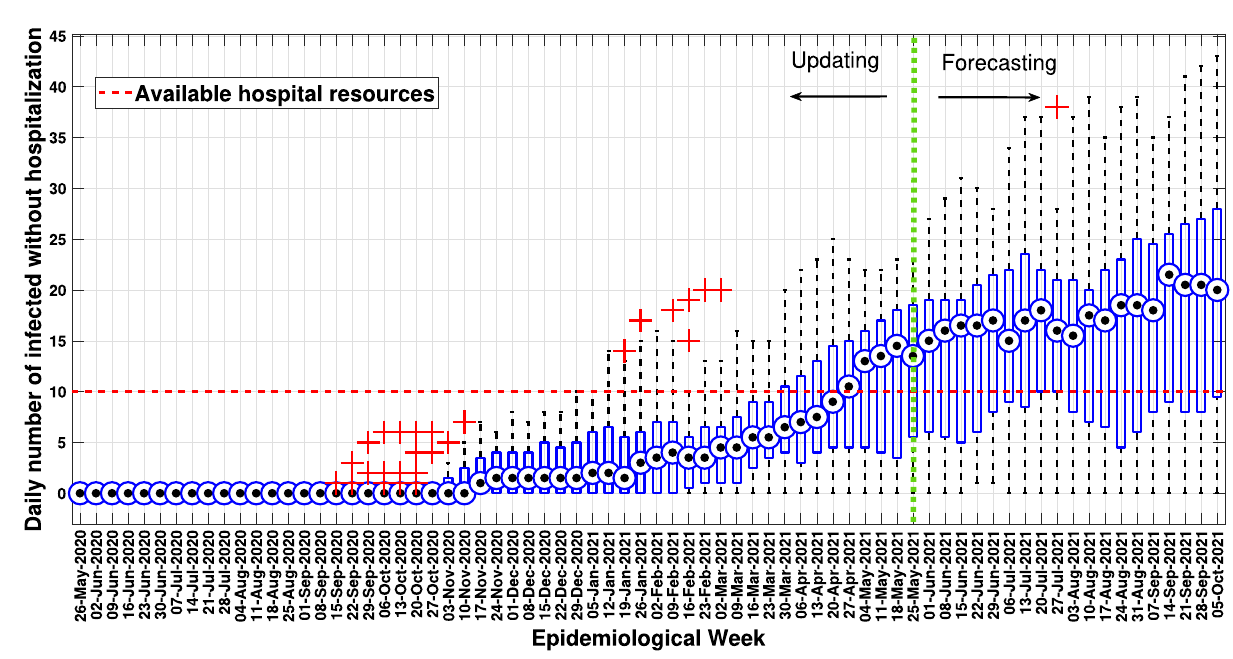
Figure 15. Boxplot analysis of demand for hospital